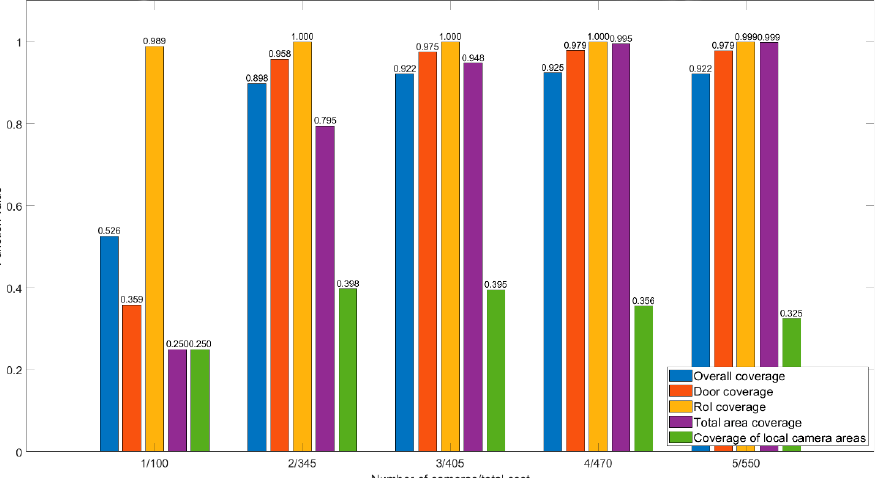
Figure 10. Function values for different number of cameras, room 1.